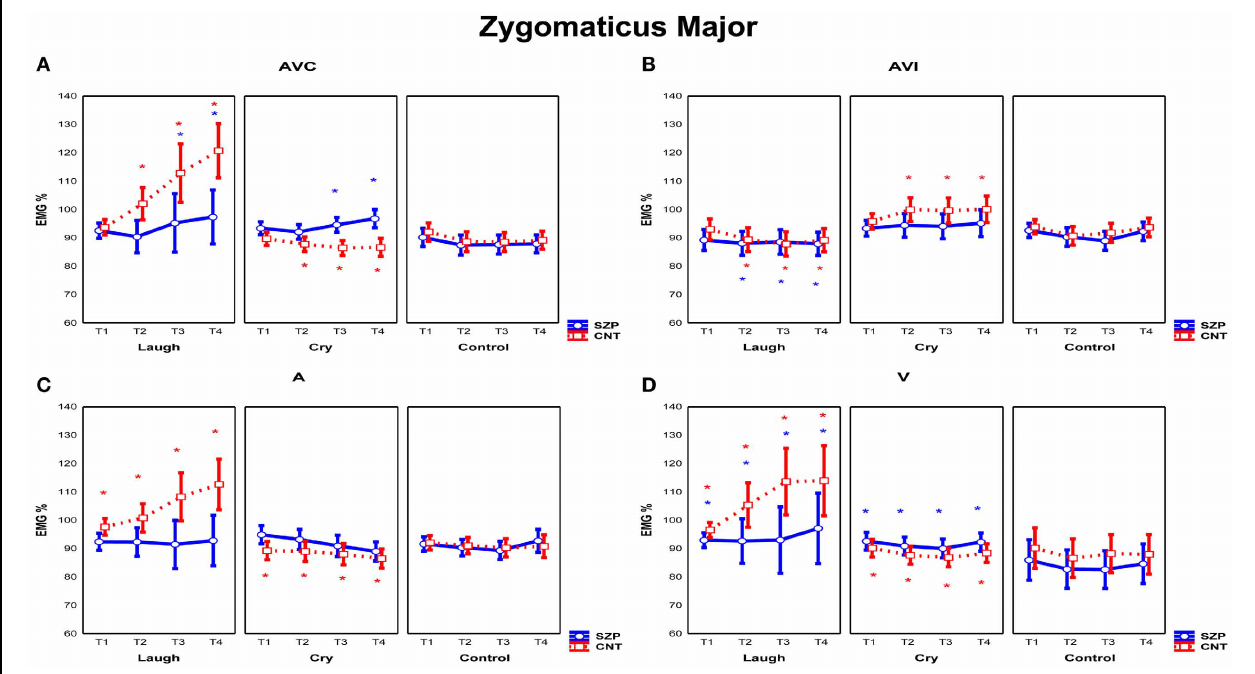
activations with respect to Control stimuli; asterisks located in the lower part of the panels indicated significant differences between emotions. Y-axis: 100% represents the mean EMG response of the baseline. X-axis: Time Periods (T1: 0–500ms, T2: 500–1000 ms, T3: 1000–1500 ms, T4: 1500–2000 ms). Error bars represent standard errors of mean ( SE ).